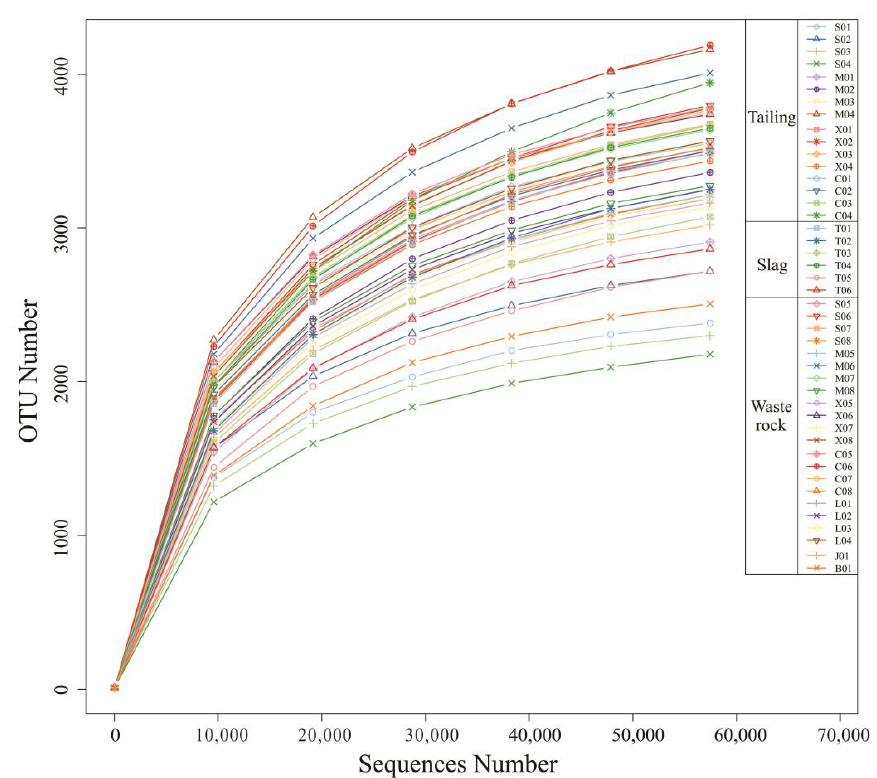
Figure 3. Rarefaction curves for the number of OTUs.